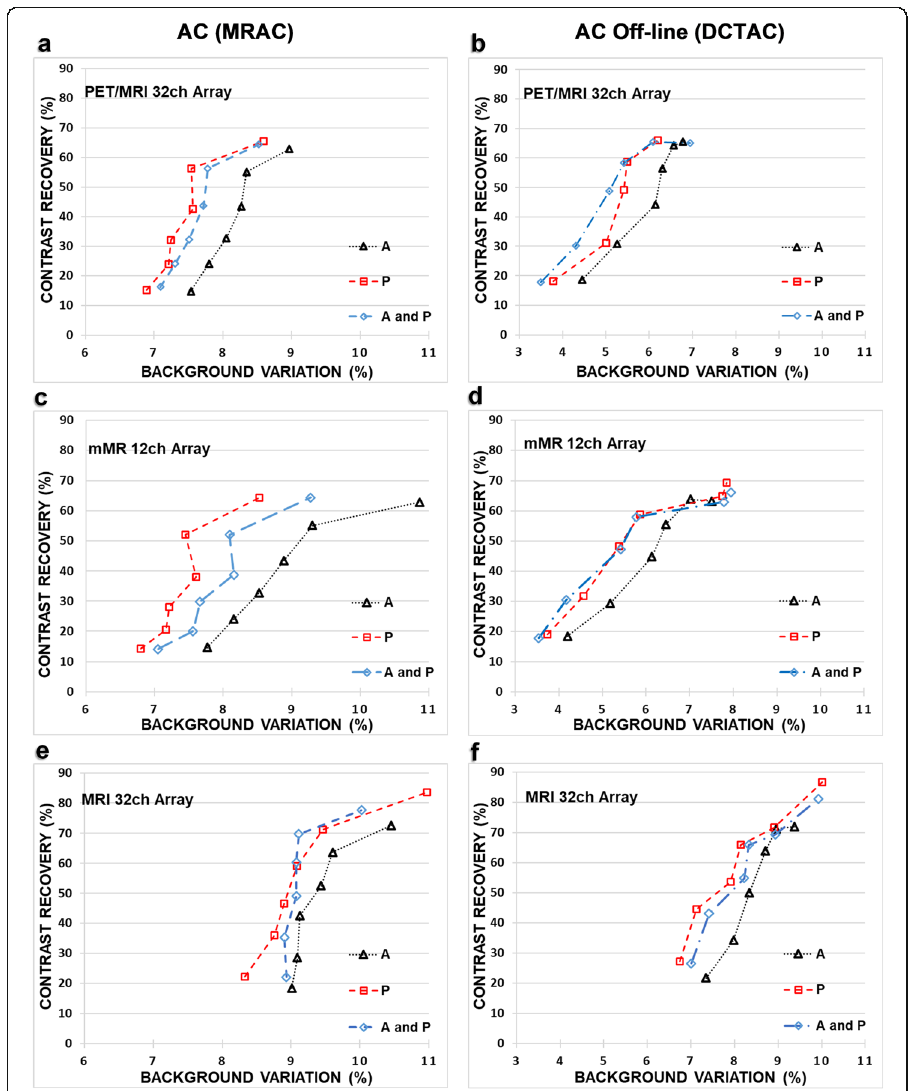
Fig. 4 CR vs. BV (from six spheres) for each array as PET reconstructed using both MRAC ( a , c and e ) and DCTAC ( b , d and f ). First data point represents the 10-mm sphere, while the last data point represents the 37-mm sphere. The A, P and A&P cases are plotted in dotted, dashed and dash-dotted lines